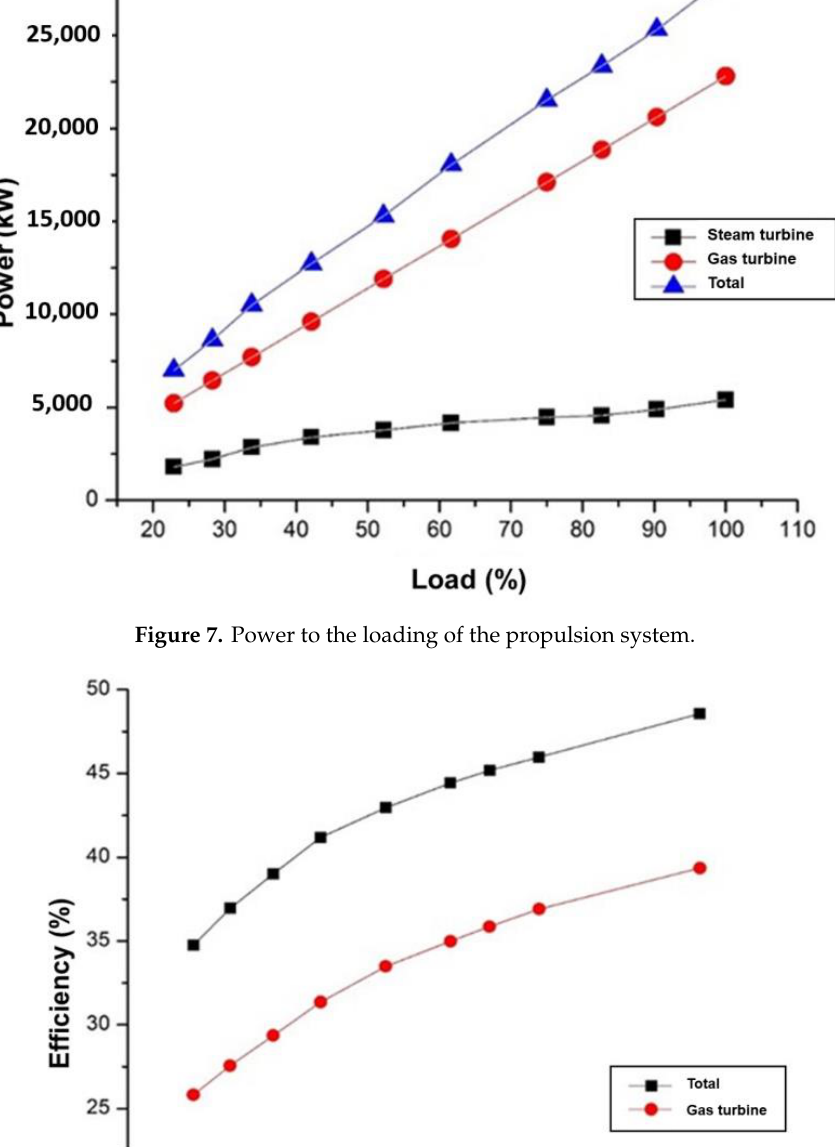
Figure 7. Power to the loading of the propulsion system.